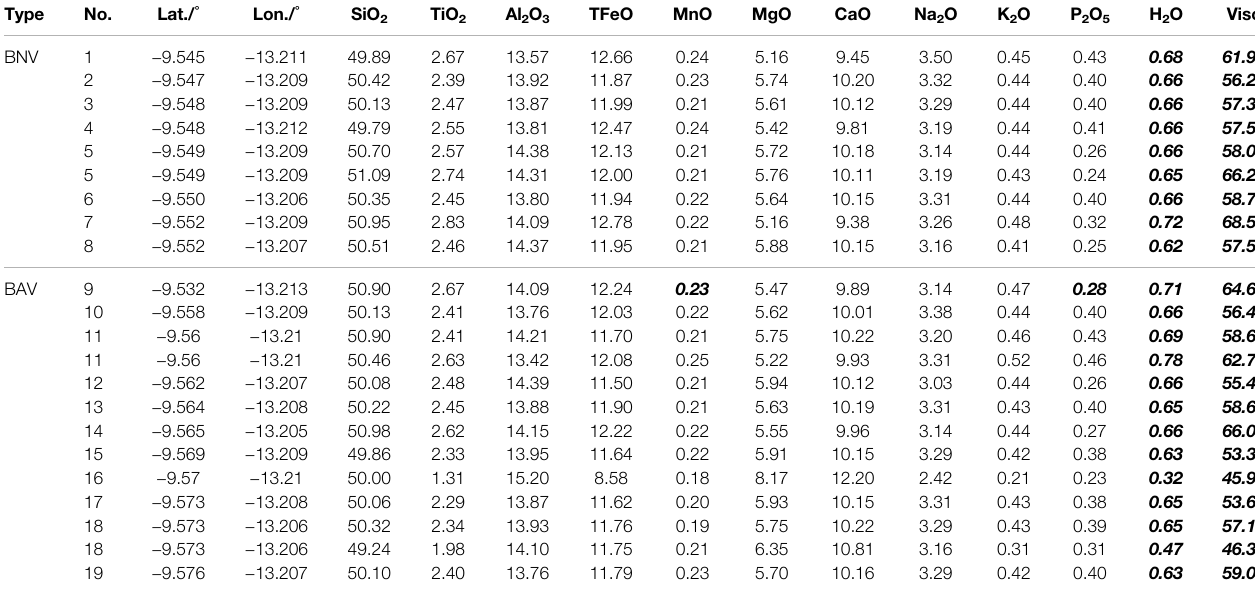
TABLE 9 | Major elements (wt%) and viscosity of basalt (Pa · s) on lilliput fi eld (data from PetDB; Haase et al., 2009). Type No. Lat./